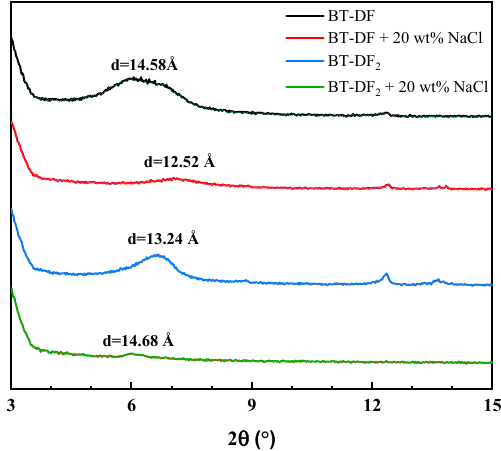
Figure 7. XRD of different BT-DF (after aging at 200 °C for 16 h).